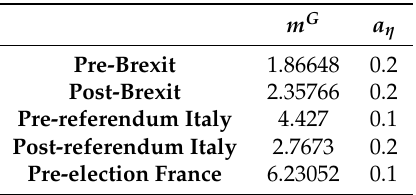
Table 1. Empirical evaluation of the impact of ambiguity: some